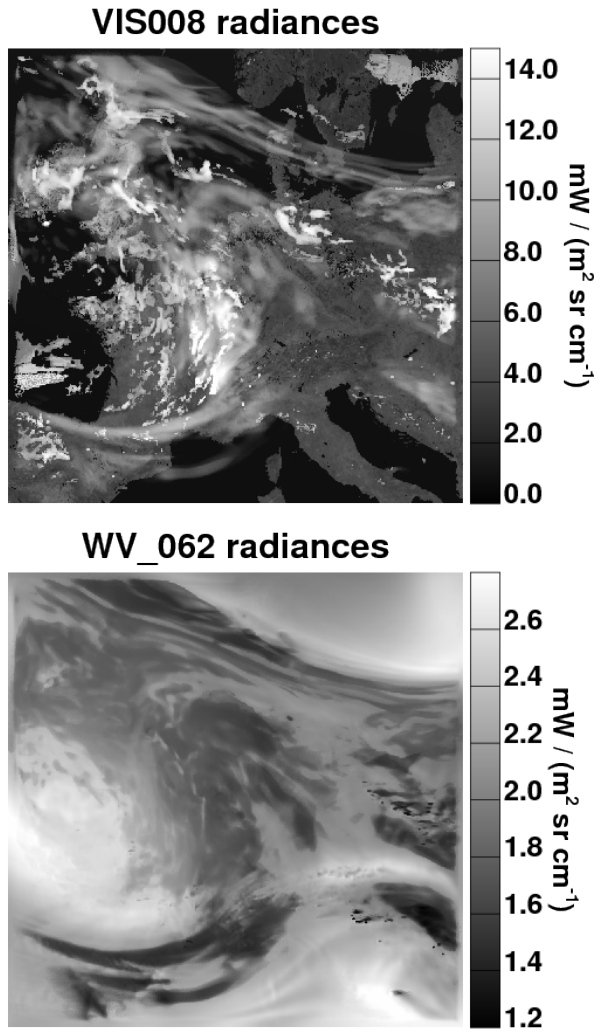
Fig. 5. Example of SEVIRI radiances computed with libRadtran: (top) solar channel VIS008 centred at 0.8µm and (bottom) water vapour channel WV 062 centred at 6.2µm. Both plots are on the MODEL grid.